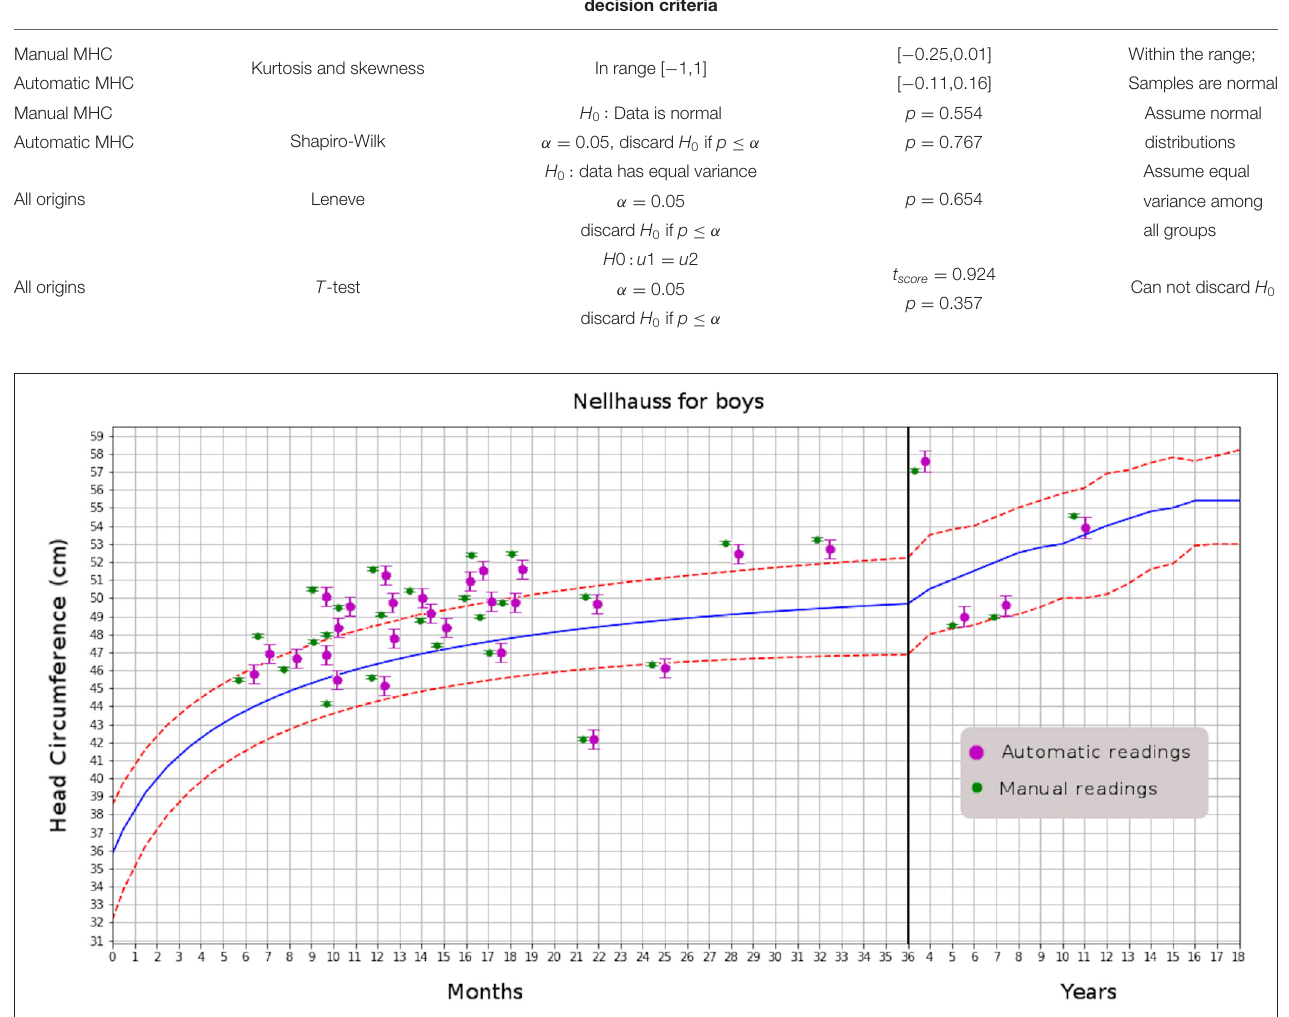
FIGURE 4 | Comparison of automatic and manual readings for boys. That for girls has similar distributions.